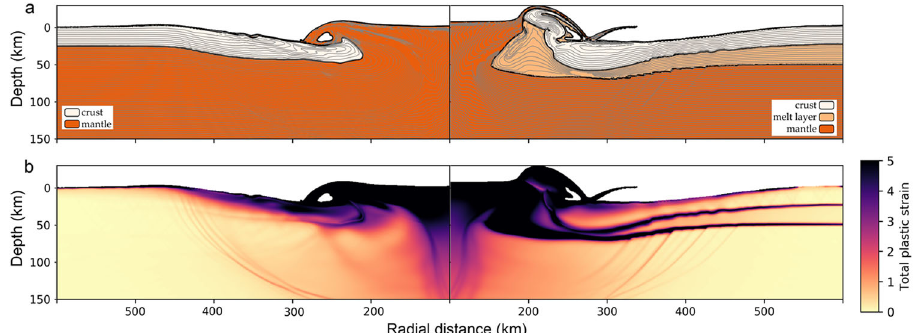
Fig. 3 Formation of topographic rings during impact-basin formation. a Snapshot of the basin stratigraphy and b total plastic strain in the late modi fi cation stage when a peak ring expected to form. The panels on the right include a melt layer between the crust and mantle, whereas the left panels show results without a melt layer. Both a , b show the formation of faults, a via fault slips represented by a change in stratigraphy, and b via localized focusing of the plastic strain. Left plots show the formation of two rings, the peak ring and the rim/outer ring (at ~270 km and 410km), typical for the large lunar basins, and the right plots show multiple faults forming at depth that are inhibited from extending to the surface due to the existence of the melt layer (its radial range is approximated from 280km to 460km). Beige colour denotes the crust, light orange is the melt layer and dark orange is the underlying solid mantle. The higher the strain the darker the colours, as shown in legend.